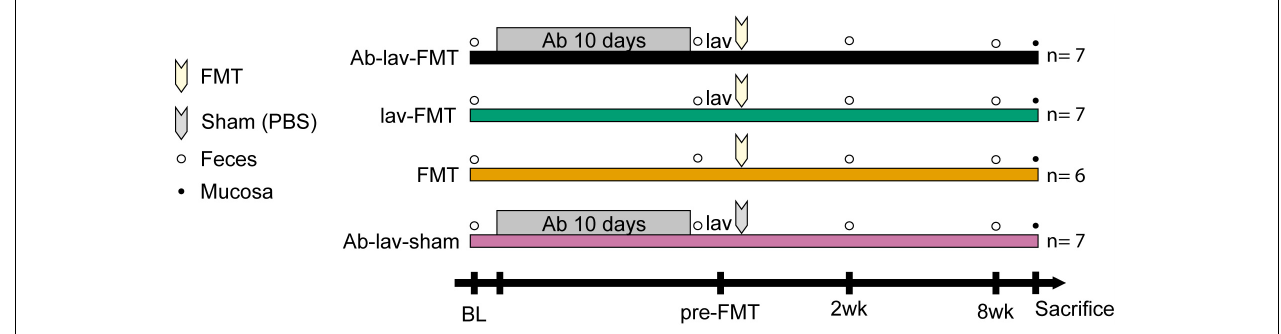
FIGURE 1 | Study design showing the treatment groups of recipient mice. After sampling of feces at baseline (recipients before treatments, BL) from four groups of mice, two groups of mice were pre-treated for 10 days with an antibiotic cocktail (Ab), consisting of 660 mg/l ciprofloxacin, 1 g/l metronidazole, and 500 mg/l vancomycin in drinking water. Two groups of mice received fecal microbiota transplantation (FMT) after bowel lavage (lav), one group received FMT without lav, and one groups received sham FMT with phosphate-buffered saline (PBS) after lav. The time points of fecal (empty bullets) or mucosal (full bullets) samplings are